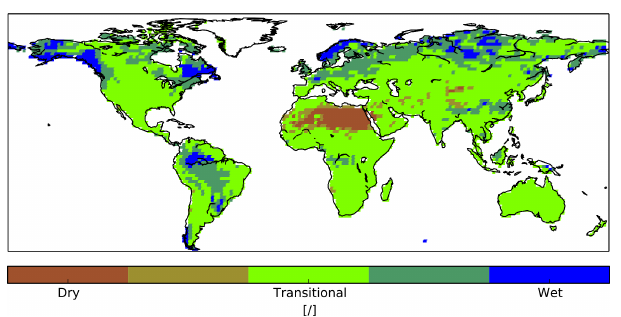
Figure 6. Soil moisture regimes based on REF climatology. Tran- sient colours mark grid cells switching between the transitional and wet/dry regimes seasonally while the others remain in their category for the whole